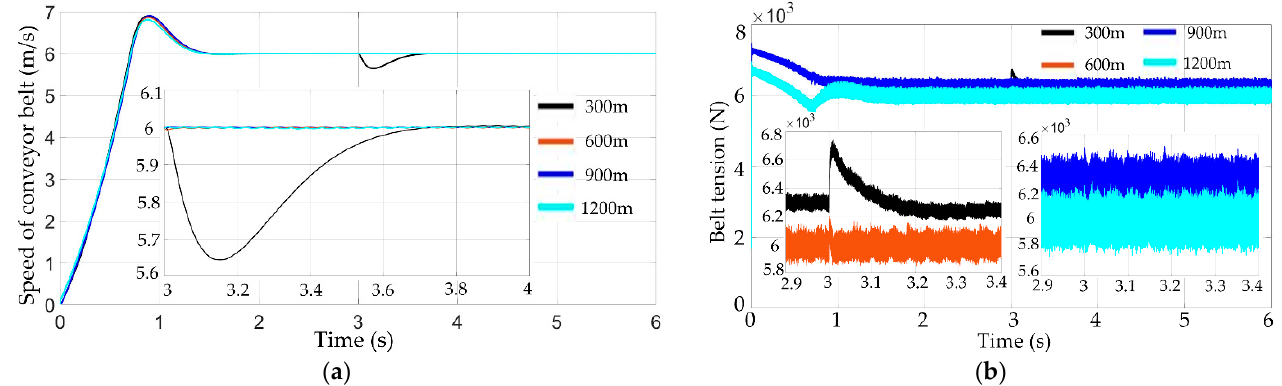
Figure 16. The response curve of conveyor belt on distributed permanent magnet direct-drive belt conveyor under variable load operation conditions. ( a ) Velocity curve; ( b ) Tension curve.